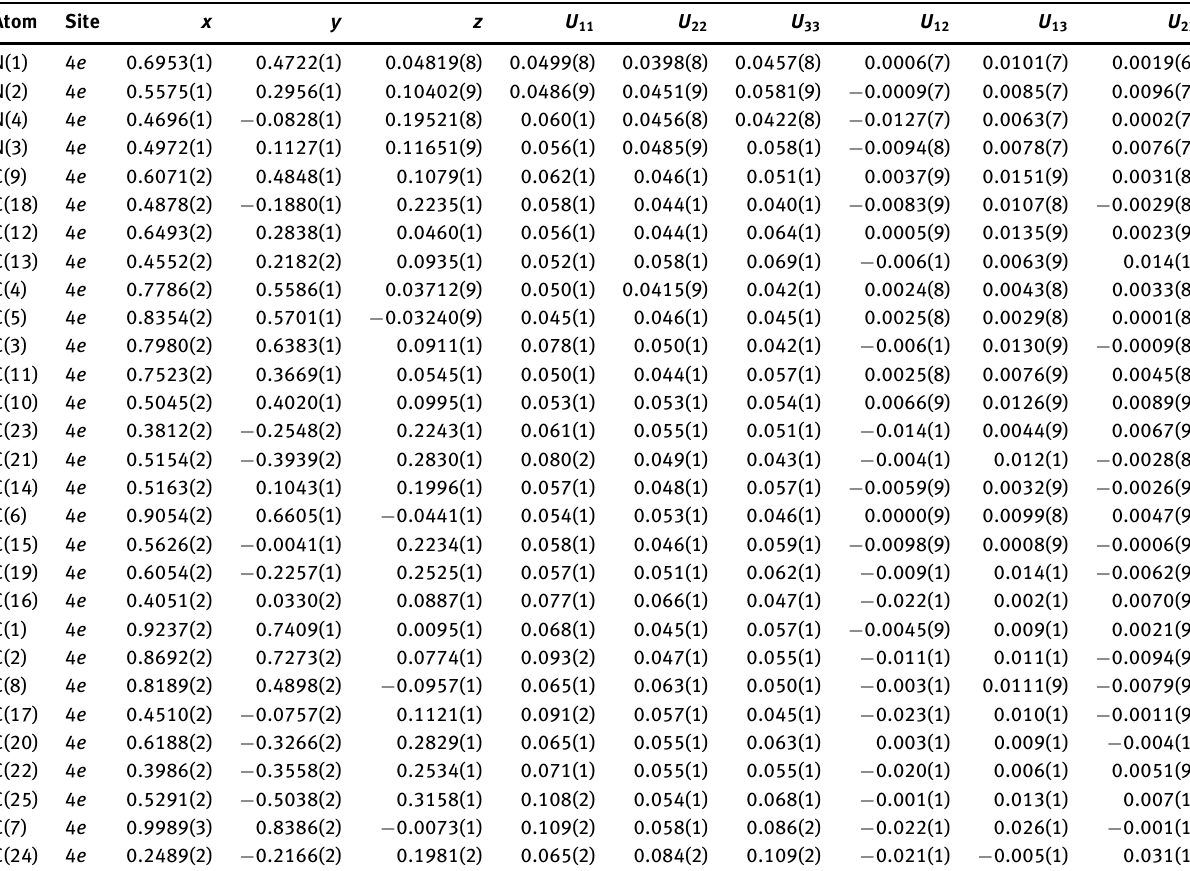
Table 3: Fractional atomic coordinate and displacement parameters (Å 2